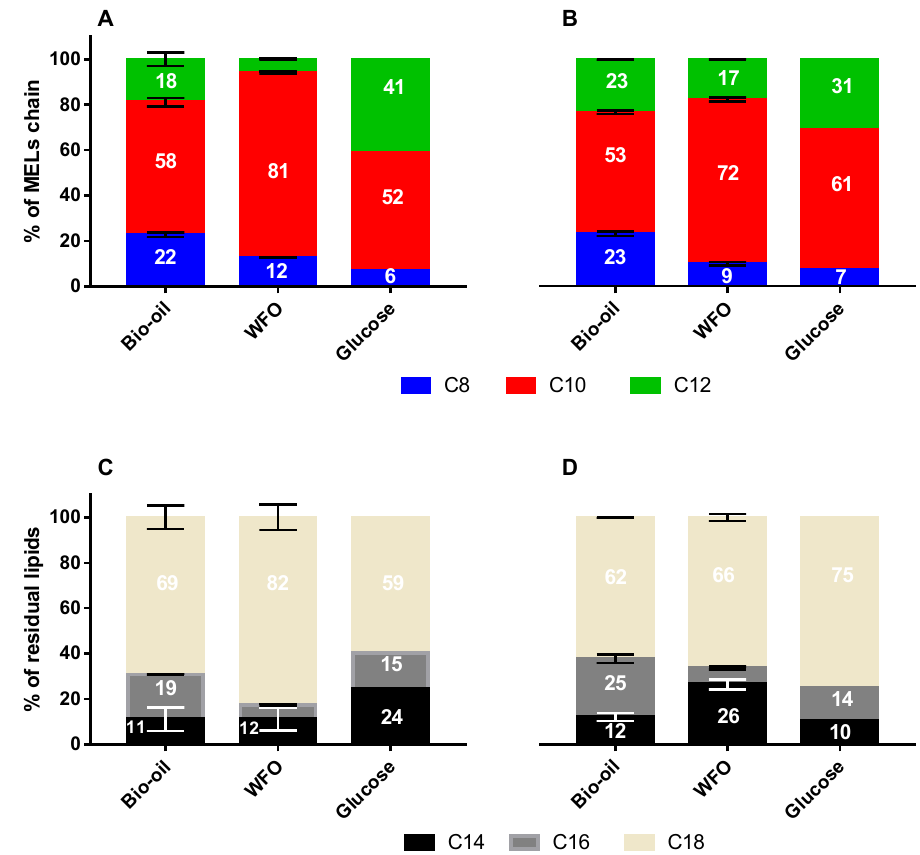
Figure 5. Type of fatty acids chains in maximum MELs titres (C8, C10, C12) and residual lipids (C14, C16, C18) produced by M. antarcticus PYCC 5048T ( A , C ) and M. aphidis PYCC 5535T ( B , D ) with different substrates used: (1) Bio-oils and D-glucose; (2) Waste frying oils and D-glucose and (3) D-glucose alone. Standard deviations values lower than 1% are not represented.